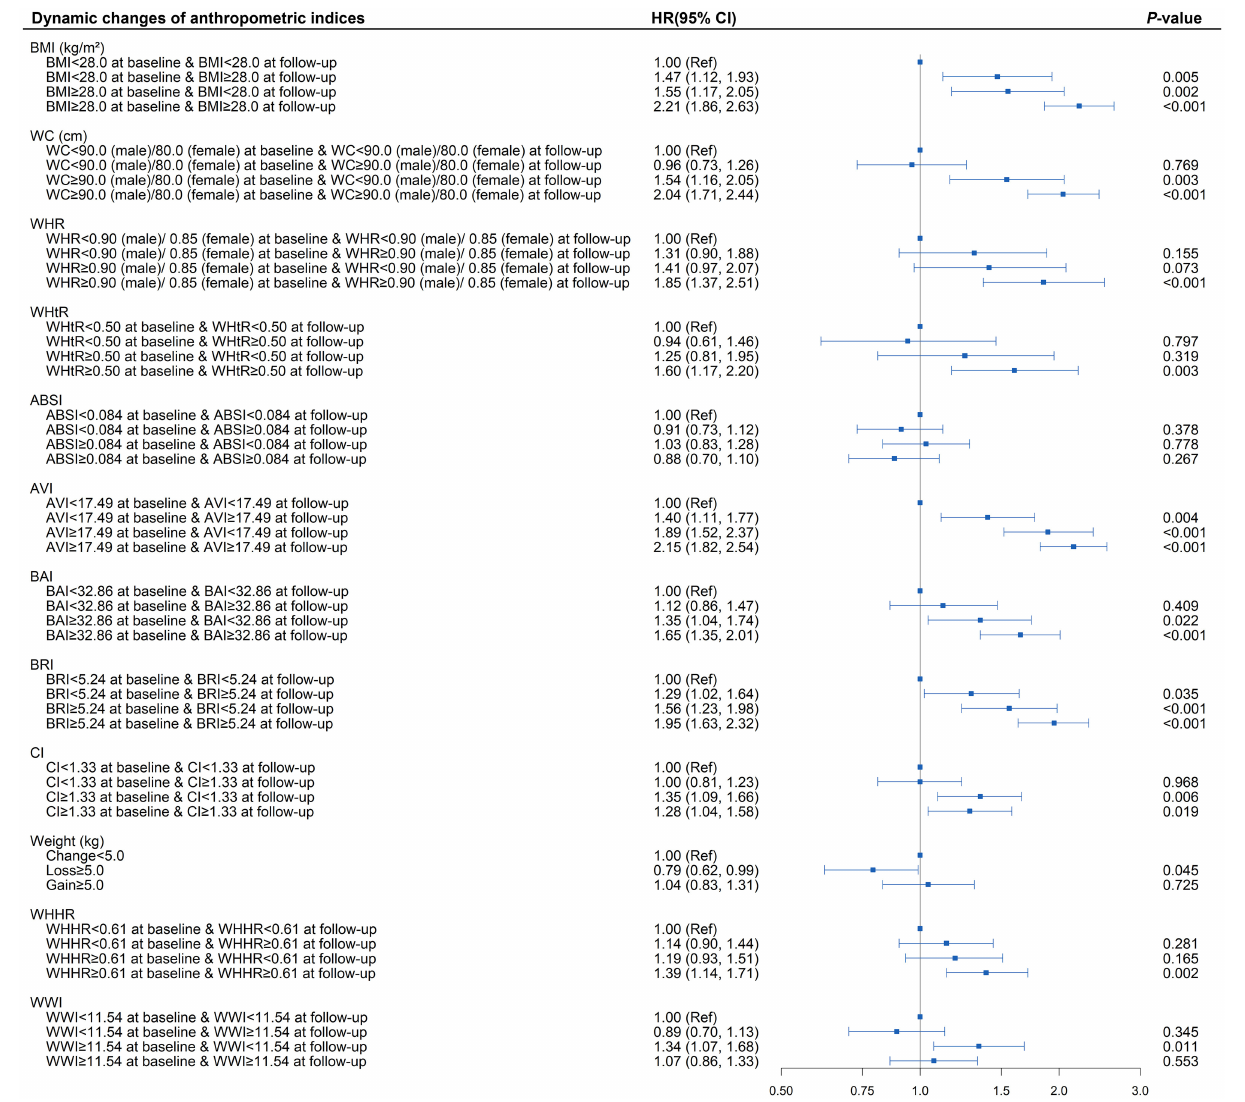
FIGURE 4 | Association between dynamic changes of separate anthropometric indices with diabetes (body mass index [BMI], waist circumference [WC], waist-to-hip ratio [WHR], waist-to-height ratio [WHtR], a body shape index [ABSI], abdominal volume index [AVI], body adiposity index [BAI], body roundness index [BRI], conicity index [CI], weight, waist-hip-height ratio [WHHR], weight-adjusted-waist index [WWI]). The correlation was assessed by multivariate cox regression analysis, adjusted by sex, age, smoking status, drinking status, fasting plasma glucose, serum triglycerides, total cholesterol, high-density lipoprotein, low-density lipoprotein,